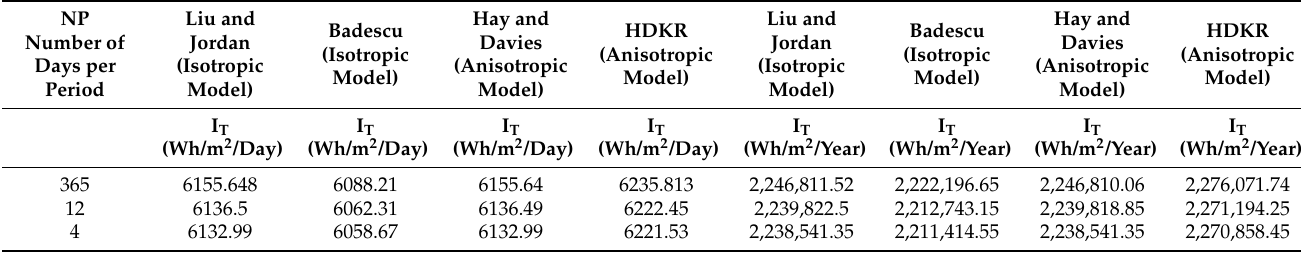
Table 10. Results comparison for Dhahran city.